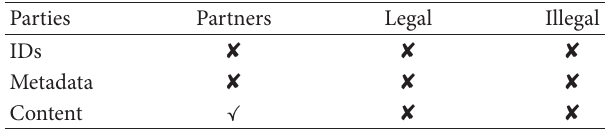
Table 3: Security, privacy, and anonymity